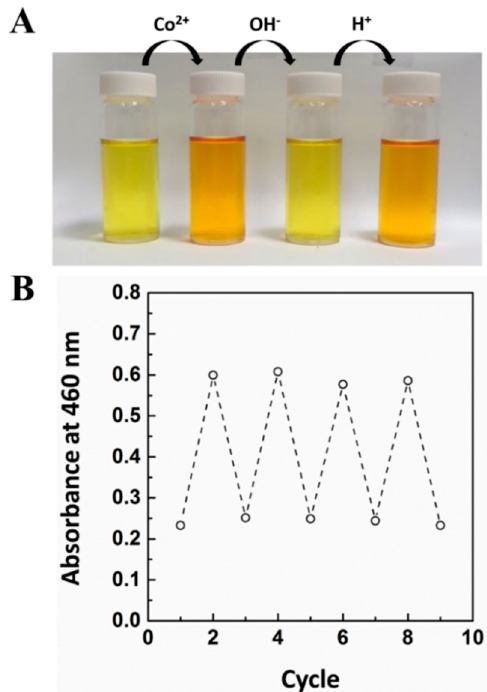
Figure 6. ( A ) Photographs of the reversibility behavior between CG chemosensor and cobalt; ( B ) Continuously repeated UV-Vis absorbance profile during stepwise “on-off” switch reaction. The concentration of CG chemosensor is 7 × 10 − 5 M.